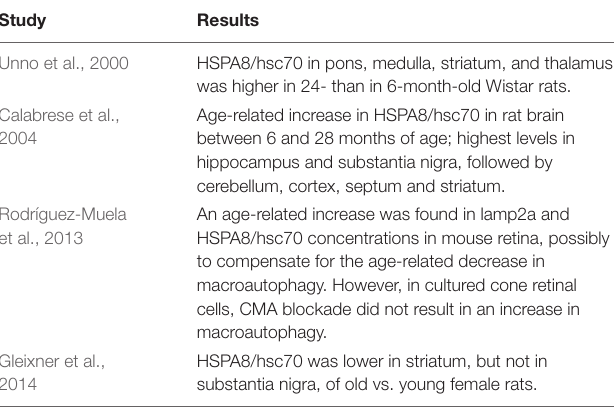
TABLE 3 | Effects of normal aging on CNS CMA in experimental